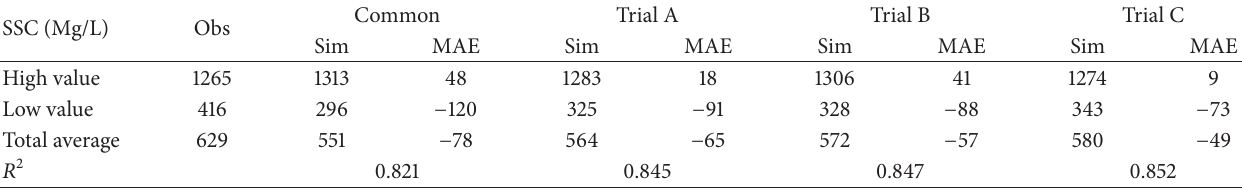
Table 2: Statistics analysis between monthly observed SSC and simulated SSC from common sediment rating curve in DRB. SSC (mg/L) Obs Simu MAE High value 1265 1313 48 Overpredict Low value 416 296 − 120 Underpredict Average 629 551 − 78 Underpredict